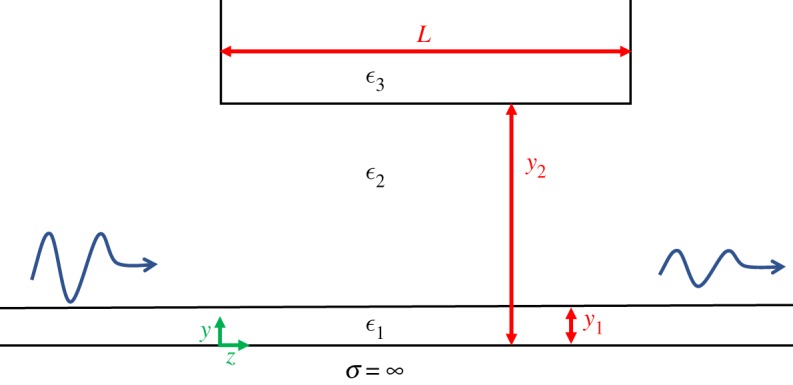
Schematic of the perturbed surface waveguide. A perfectly conducting plane, coated by a dielectric ϵ1 of thickness y1 and surrounded by a material with dielectric constant ϵ2, is perturbed by a dielectric ϵ3 at a distance y2 from the conductor. It extends for a length L along the propagation direction. The system is assumed to be infinite in the paper plane and a two-dimensional Cartesian coordinate system (y, z) is shown. A signal incident from the left is attenuated as part of the energy is turned into radiation over the perturbed region. (Online version in colour.)